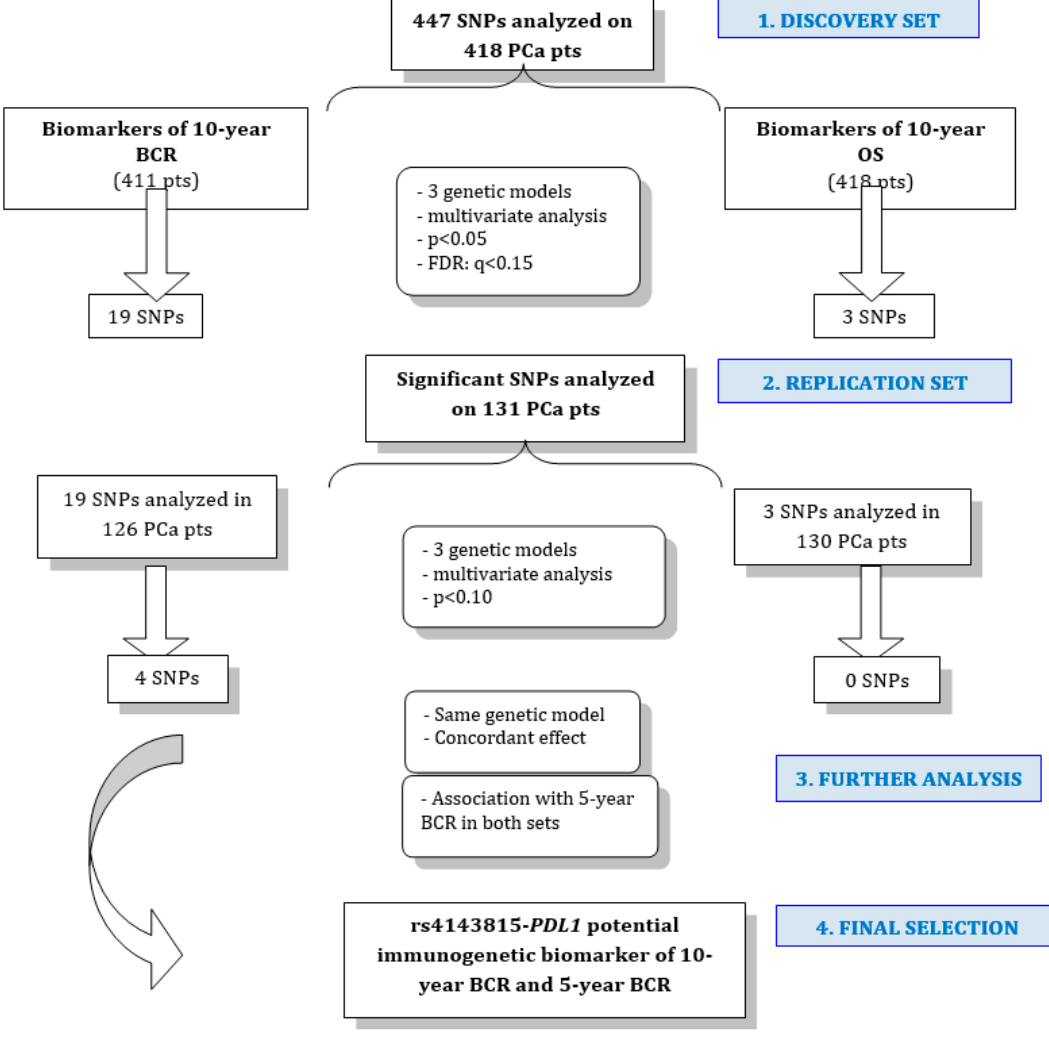
Figure 2. Study design. Firstly, analyses were performed on a discovery set and secondly, in a replication set. At the end of the study, rs4143815-PDL1 arose as a new potential immunogenetic biomarker of 10 year and 5 year BCR in locally advanced prostate cancer. Abbreviations: PCa, prostate cancer; BCR: biochemical recurrence; OS: overall survival; pts: patients.